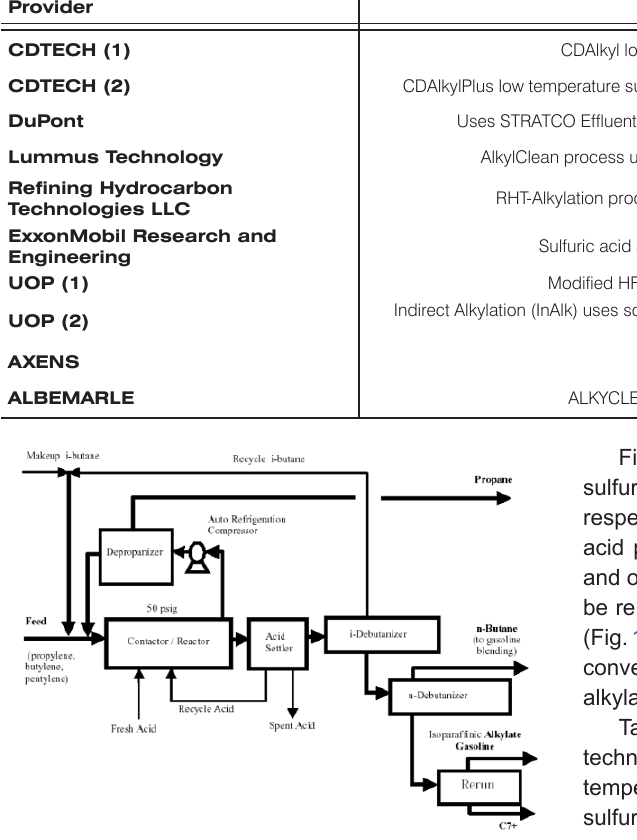
Figure 11. Sulfuric Acid catalyzed Alkylations [38].